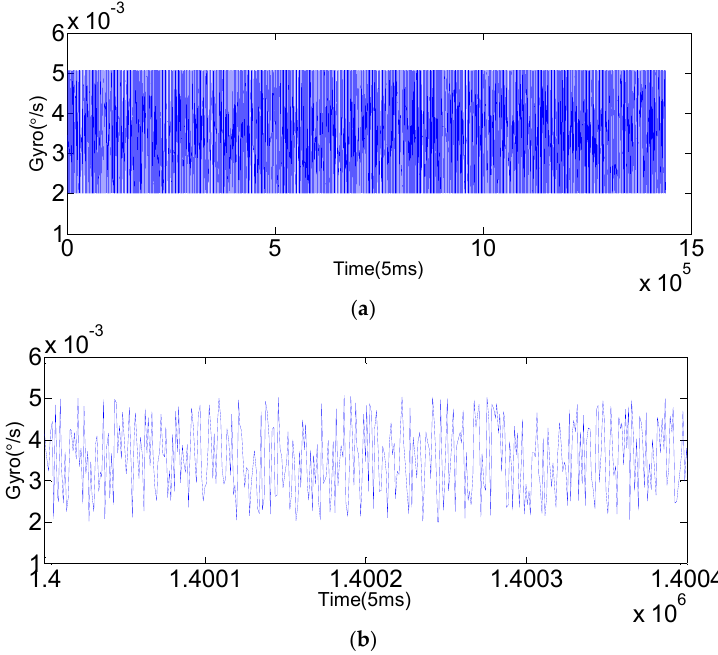
Figure 8. The filtering result of KF. ( a ) The filtering result of a single axis ( x -axis) FOG for 2 h; ( b ) local enlarged graphs.